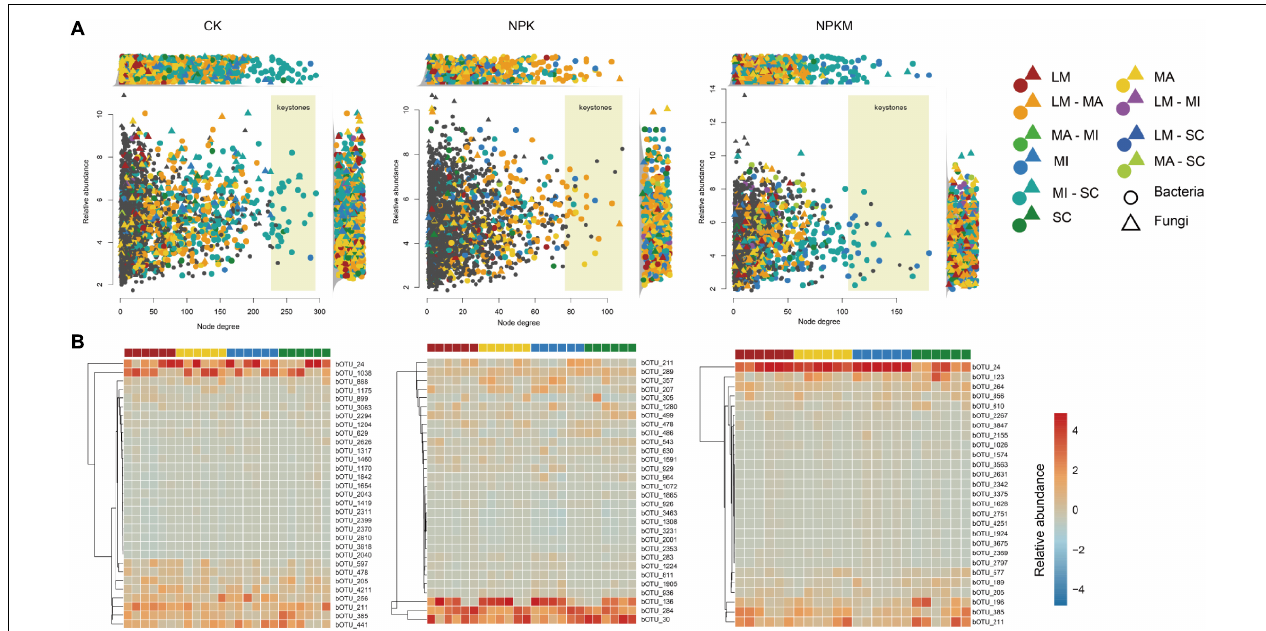
FIGURE 5 | Identified soil aggregation-sensitive OTUs (asOTUs) and keystones. (A) Degree of co-occurrence and abundances of asOTUs. Relative abundances (as counts per million, CPM) of all OTUs from co-occurrence networks ( Figure 4 ) were plotted as a function of their degrees of co-occurrence. OUTs were colored by their associations to soil aggregate fractions, and circle and triangle represented bacteria and fungi, respectively. OUTs in the yellow background were identified as keystones. Top panels revealed the distribution of node degrees and side panels revealed the relative abundances of all asOTUs. (B) Relative abundances of bacterial keystones determined by co-occurrence network. Keystones was centroid clustered by Euclidean distance. The deeper the color is, the higher relative abundance of keystones is. B, bacteria; F, fungi, others see Figure 1